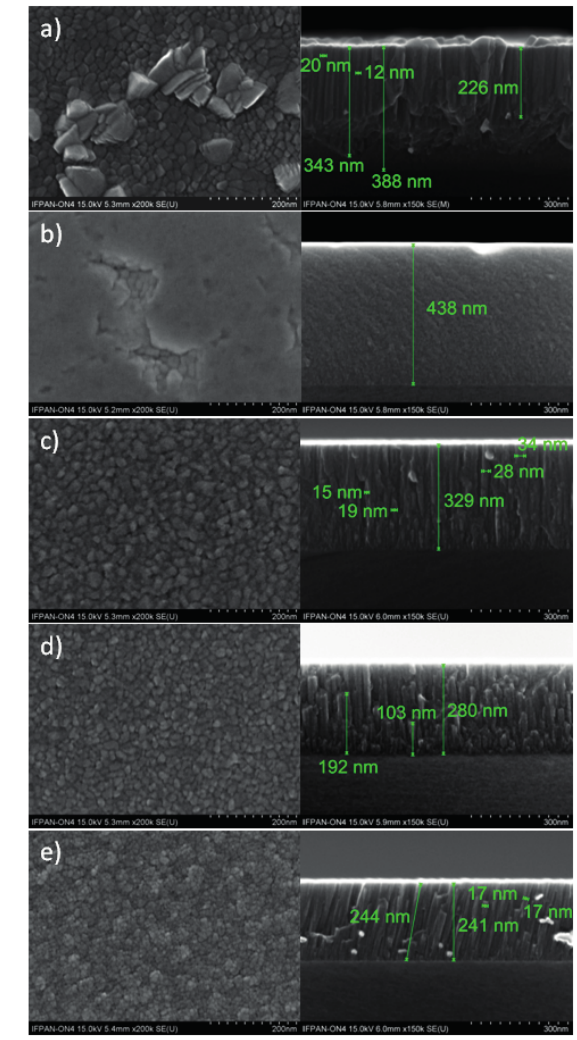
Figure 3: SEM (Hitachi SU-70, Institute of Physics, Polish Academy of Sciences, IFPAN) images of non-stoichiometric TiO :N thin 2-x films deposited at different nitrogen flow rates a) η =0 sccm N2 b) η =0.27 sccm c) η =0.53 sccm d) η =0.67 sccm e) η =0.8 sccm. N2 N2 N2 N2 Two types of images are included: top surface view (left side column) and cross-section view (right side